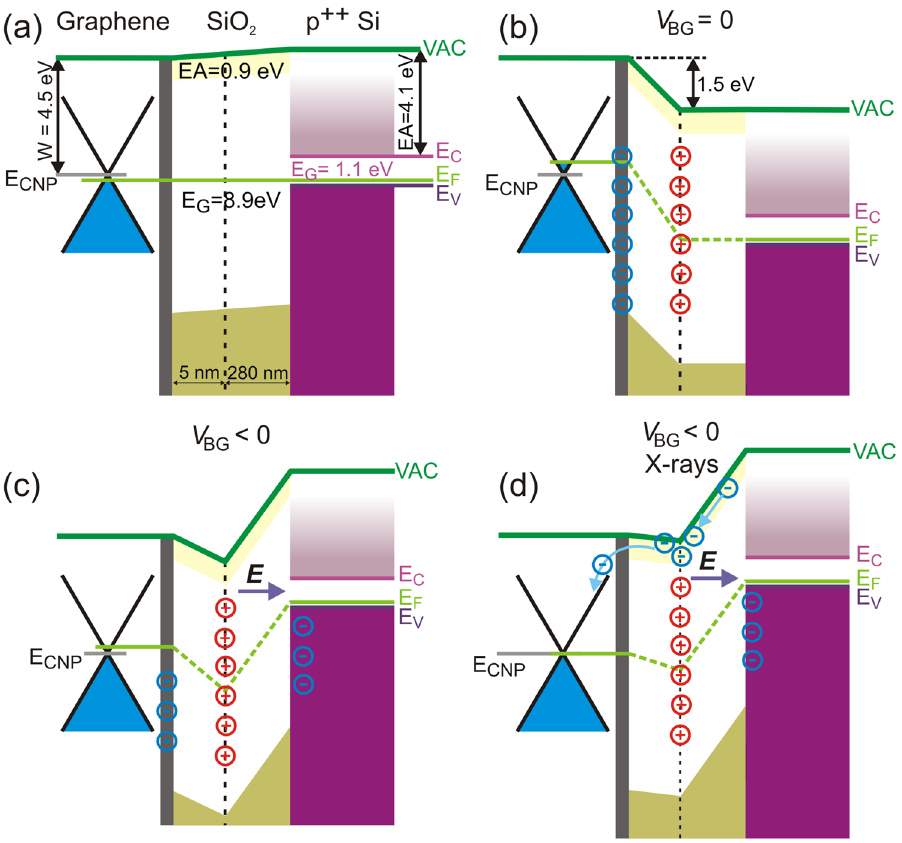
Figure 2. Schematic of the band diagrams of the GFET device. ( a ) The band alignment for the pristine device as adapted from refs 36, 37. ( b ) For the X-ray irradiated device the built in positive charge induces n-doping of graphene and the formation of a potential barrier. ( c ) If the negative V BG is applied to the gate, the potential barrier is partially decreased and transformed into a potential well. ( d ) The photoexcited electrons localized in the SiO 2 conduction band will be drifted by an applied electric field and accumulate near the location of the positive charge. The accumulated electrons will cause a decrease of the barrier to such an extent so that they can eventually cross